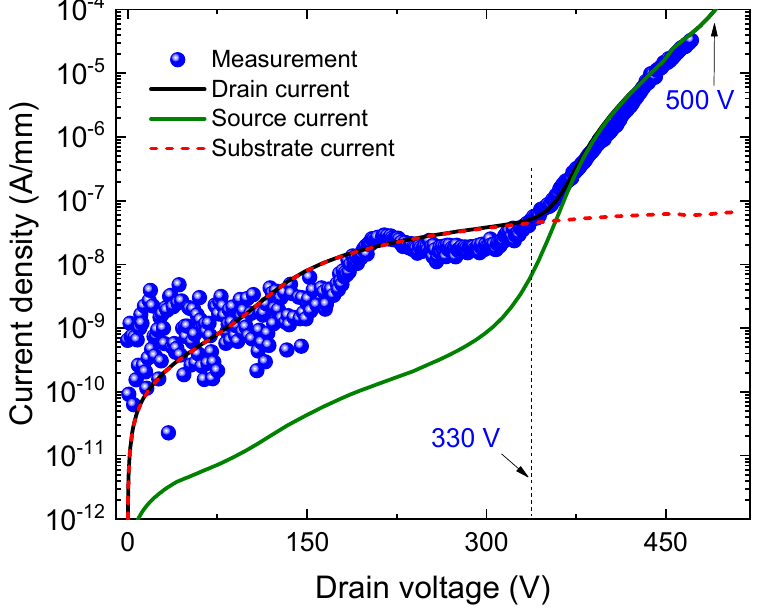
Figure 4. Experimental (doted) and simulated (line) AlGaN/GaN MOS-HEMT breakdown.